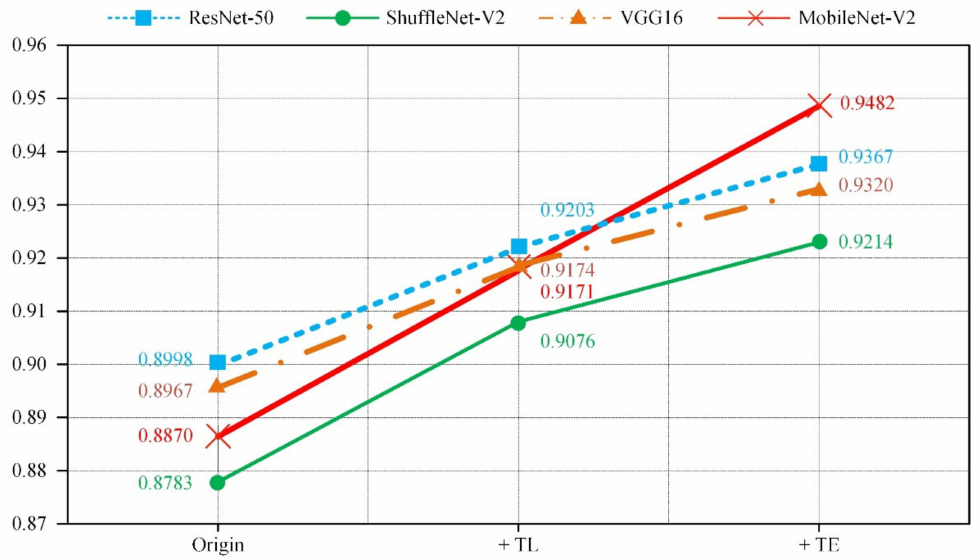
Figure 10. The variation of balanced accuracy of different models after introducing Transformer Encoder. TL means transfer learning. TE represents Transformer Encoder.